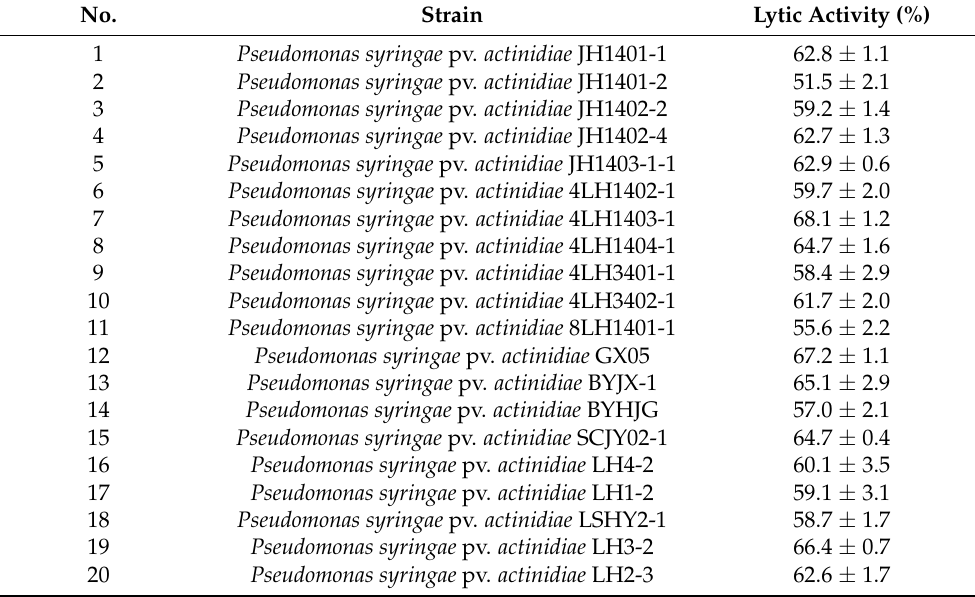
Table 2. The lytic spectrum of endolysin